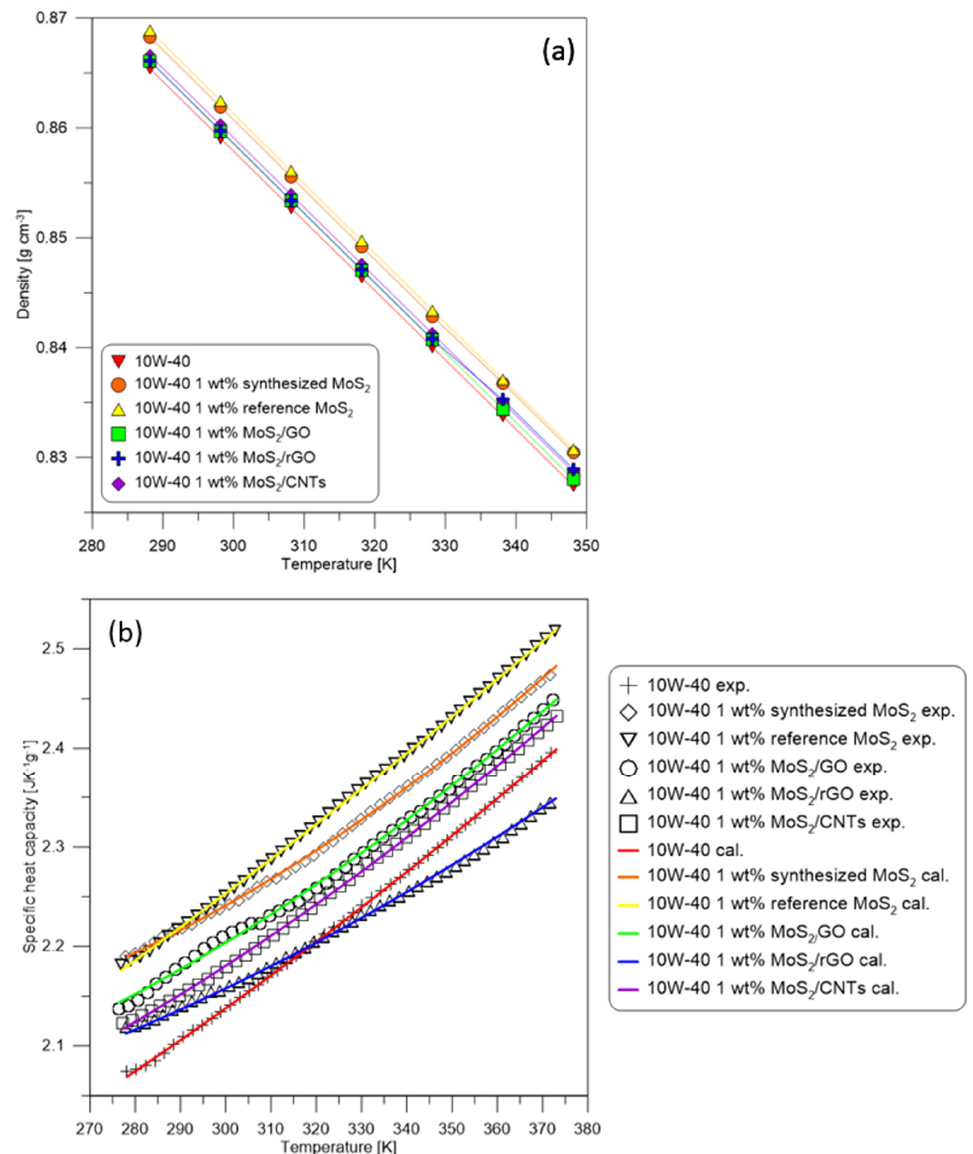
Figure 1. ( a ) Density and ( b ) specific heat capacity as a function of temperature of the base oil 10W40 and nanosuspensions with the addition of synthesized MoS 2 , reference MoS 2 , MoS 2 /GO, MoS 2 /rGO, and MoS 2 /CNTs. Table 1. Constants in the equations approximating the density ( a , b ) with correlation coefficient ( R 2 ) and specific heat capacity ( A , B , C , D ) as a function of temperature of nanosuspensions. Engine Oil